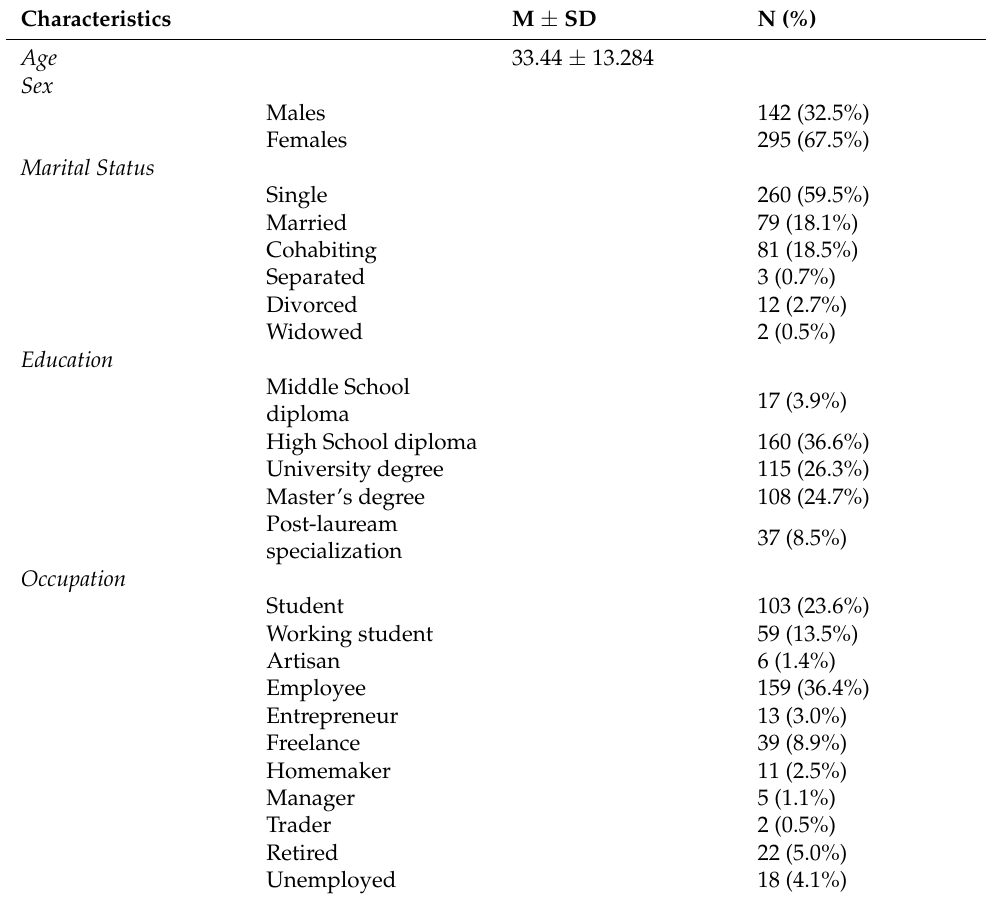
Table 1. Demographic characteristics of the sample ( N =